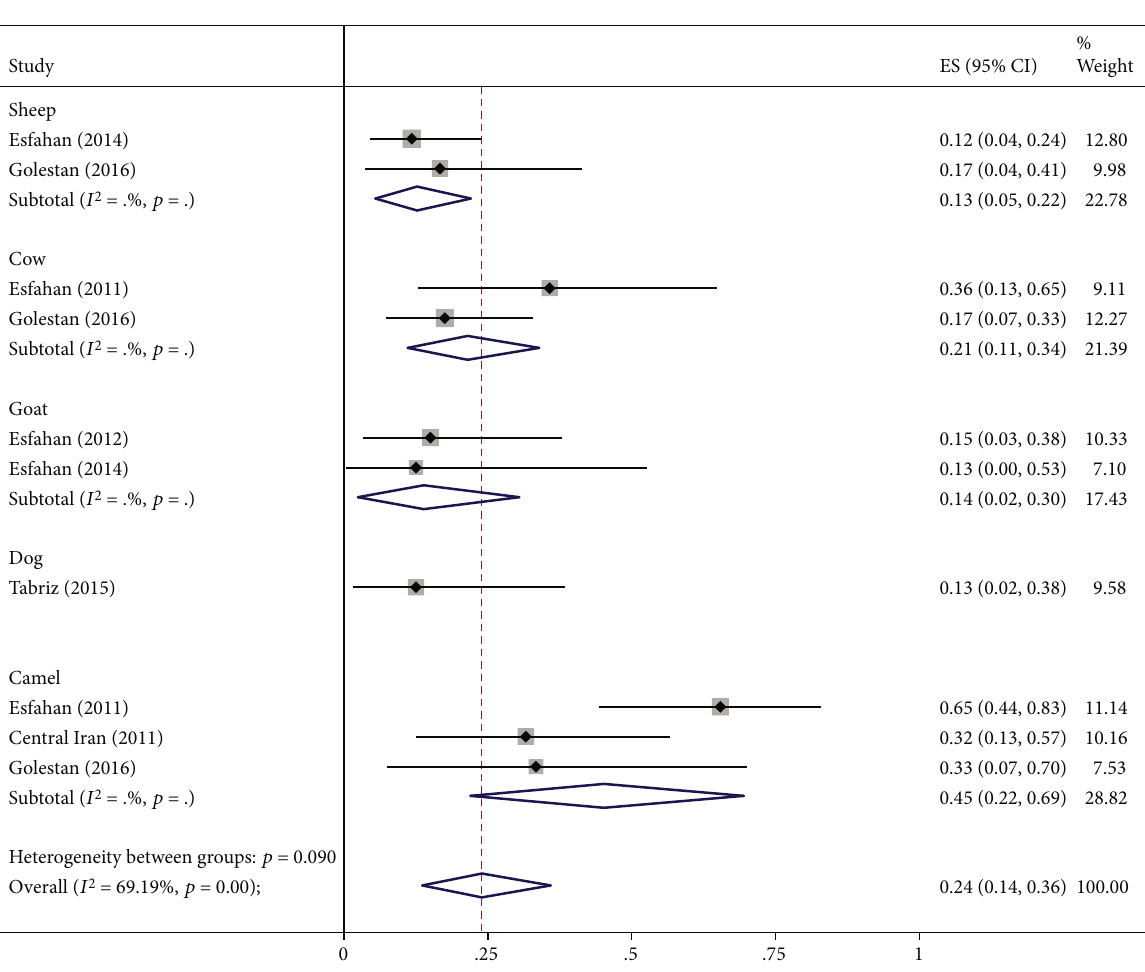
genotype prevalence by animal 6